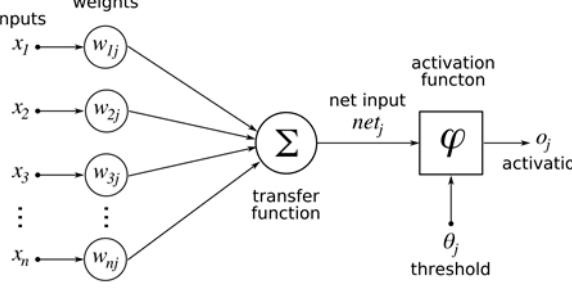
Figure 1. Artificial neuron. (Source: Own processing.).